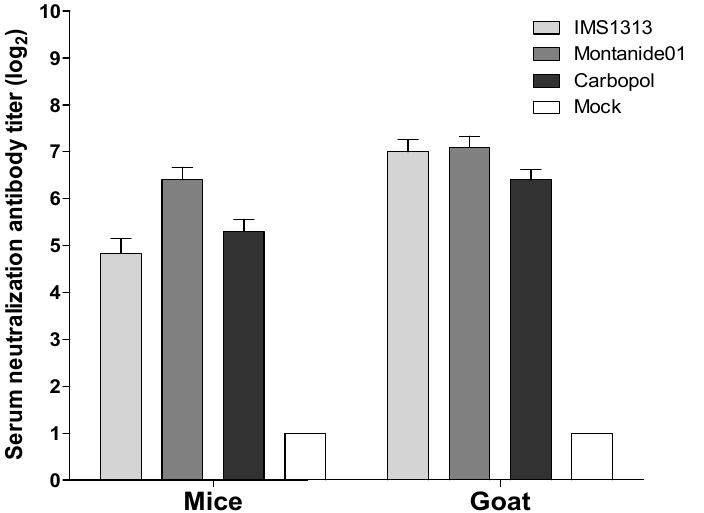
Figure 4. Antibody titers in mice and goats inoculated with the inactivated KBR-1 vaccine. Anti-BCoV antibody titers at 2 weeks post-injection of the inactivated KBR-1 vaccine mixed with Carbopol, Montanide01, or IMS1313. Table 4. Detection of BCoV antigen and antibodies, and diarrhea scores after vaccination and challenge with BCoV